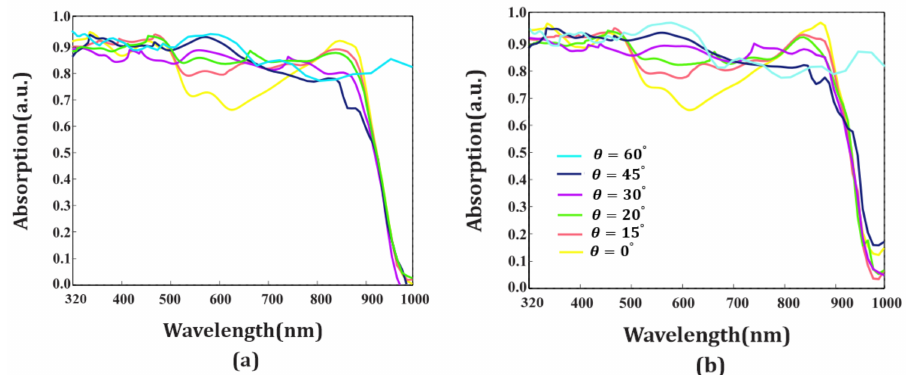
Figure 11. Absorption spectra for inclined radiation for ( a ) bare cell and ( b ) proposed cell.